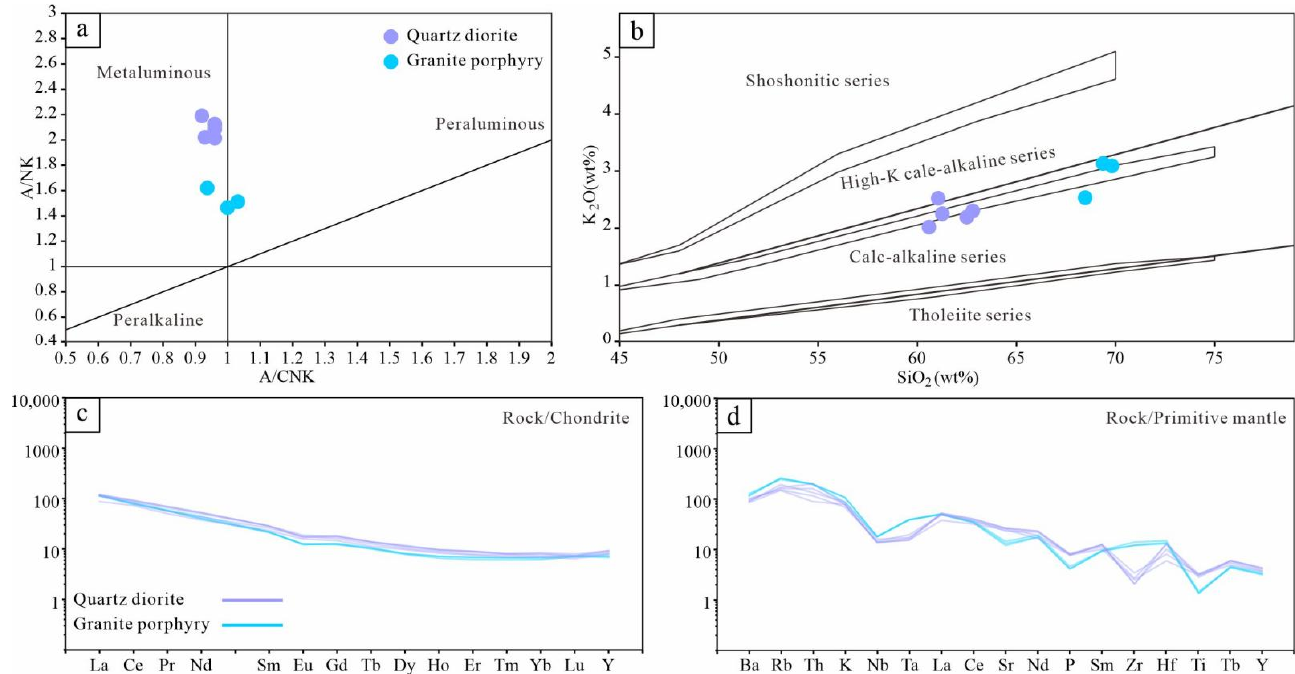
Figure 5. Discrimination diagrams for the granitoid. A/CNK–A/NK ( a ), SiO 2 –K 2 O ( b ) diagrams, chondrite-normalized REE diagram ( c ), and primitive mantle-normalized trace element spider dia- gram ( d ). Figure 5 a is modified from [38]. Figure 5 b is modified from [39]. Primitive mantle data are from [40,41].